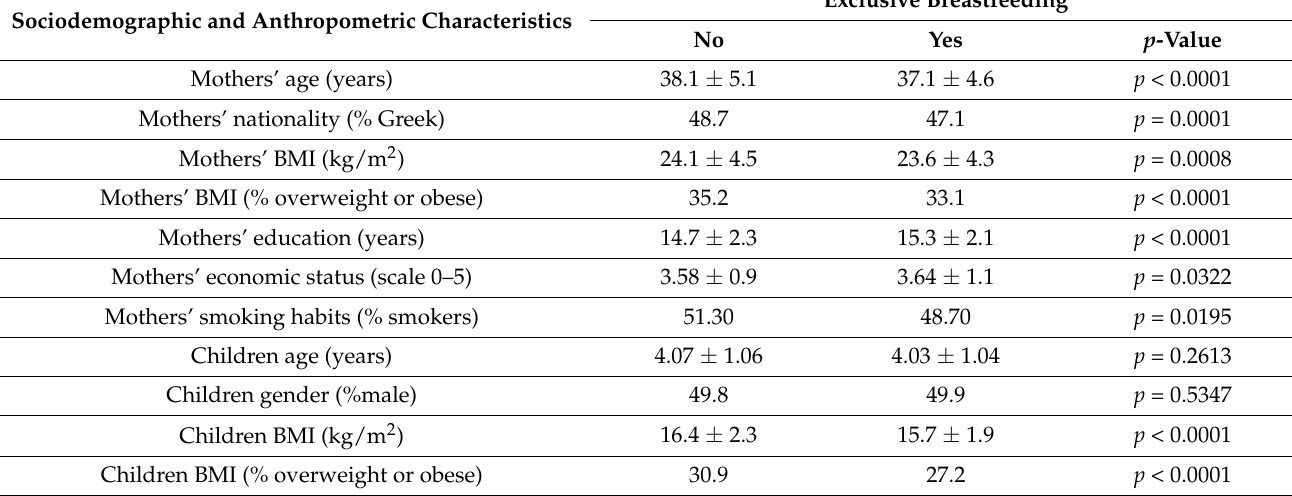
Table 1. Associations of exclusive breastfeeding for at least 4 months with sociodemographic and anthropometric characteristics for mothers 2–5 years after delivery and their